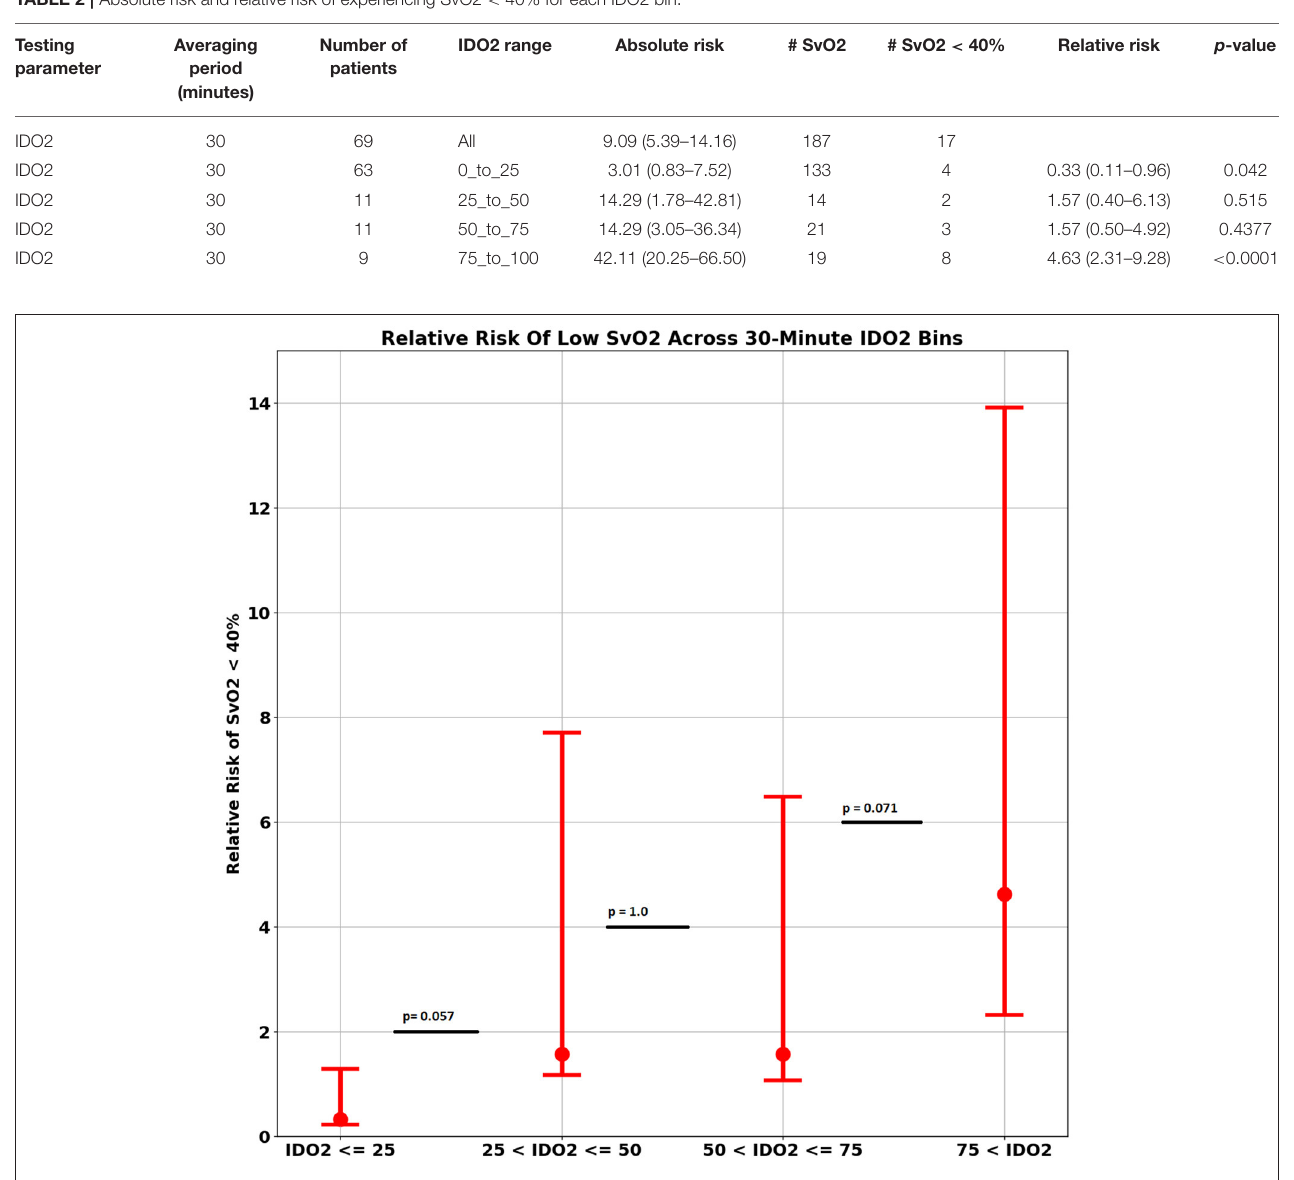
FIGURE 2 | Relative risk of low SvO2 across 30-min IDO2